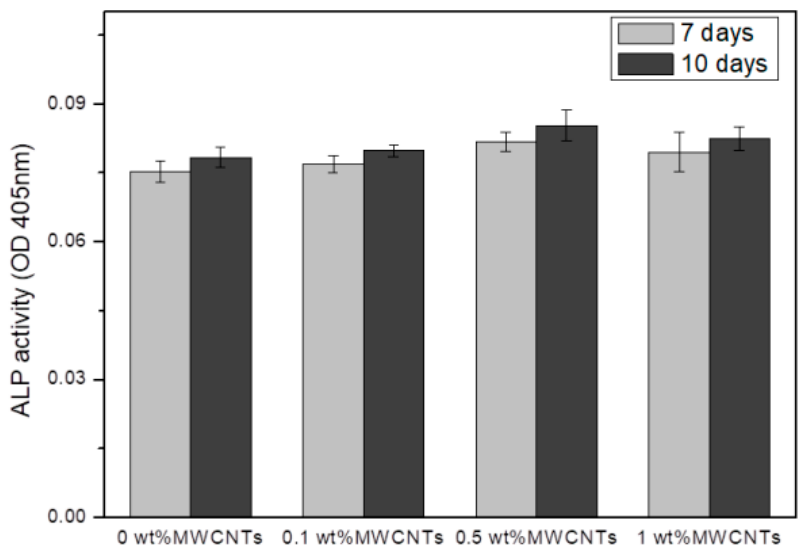
Figure 6. Alkaline phosphatase (ALP) activity of the MC3T3-E1 cells. The cells were cultured for 7 and 10 days on the MWCNTs-HA nanocomposite with various MWCNT contents (0 wt %, 0.1 wt %, 0.5 wt % and 1 wt %) coating on titanium.